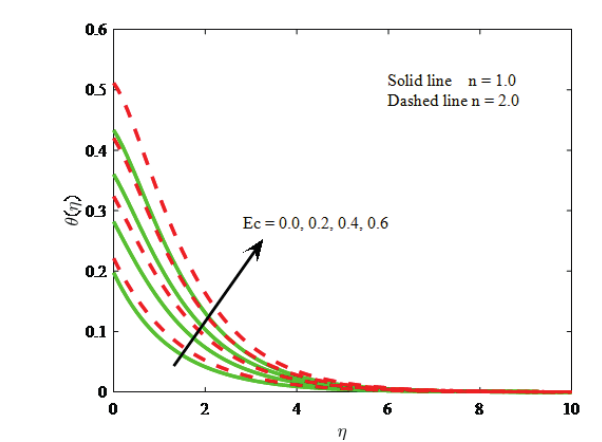
Fig. 12: Impact of Ec on